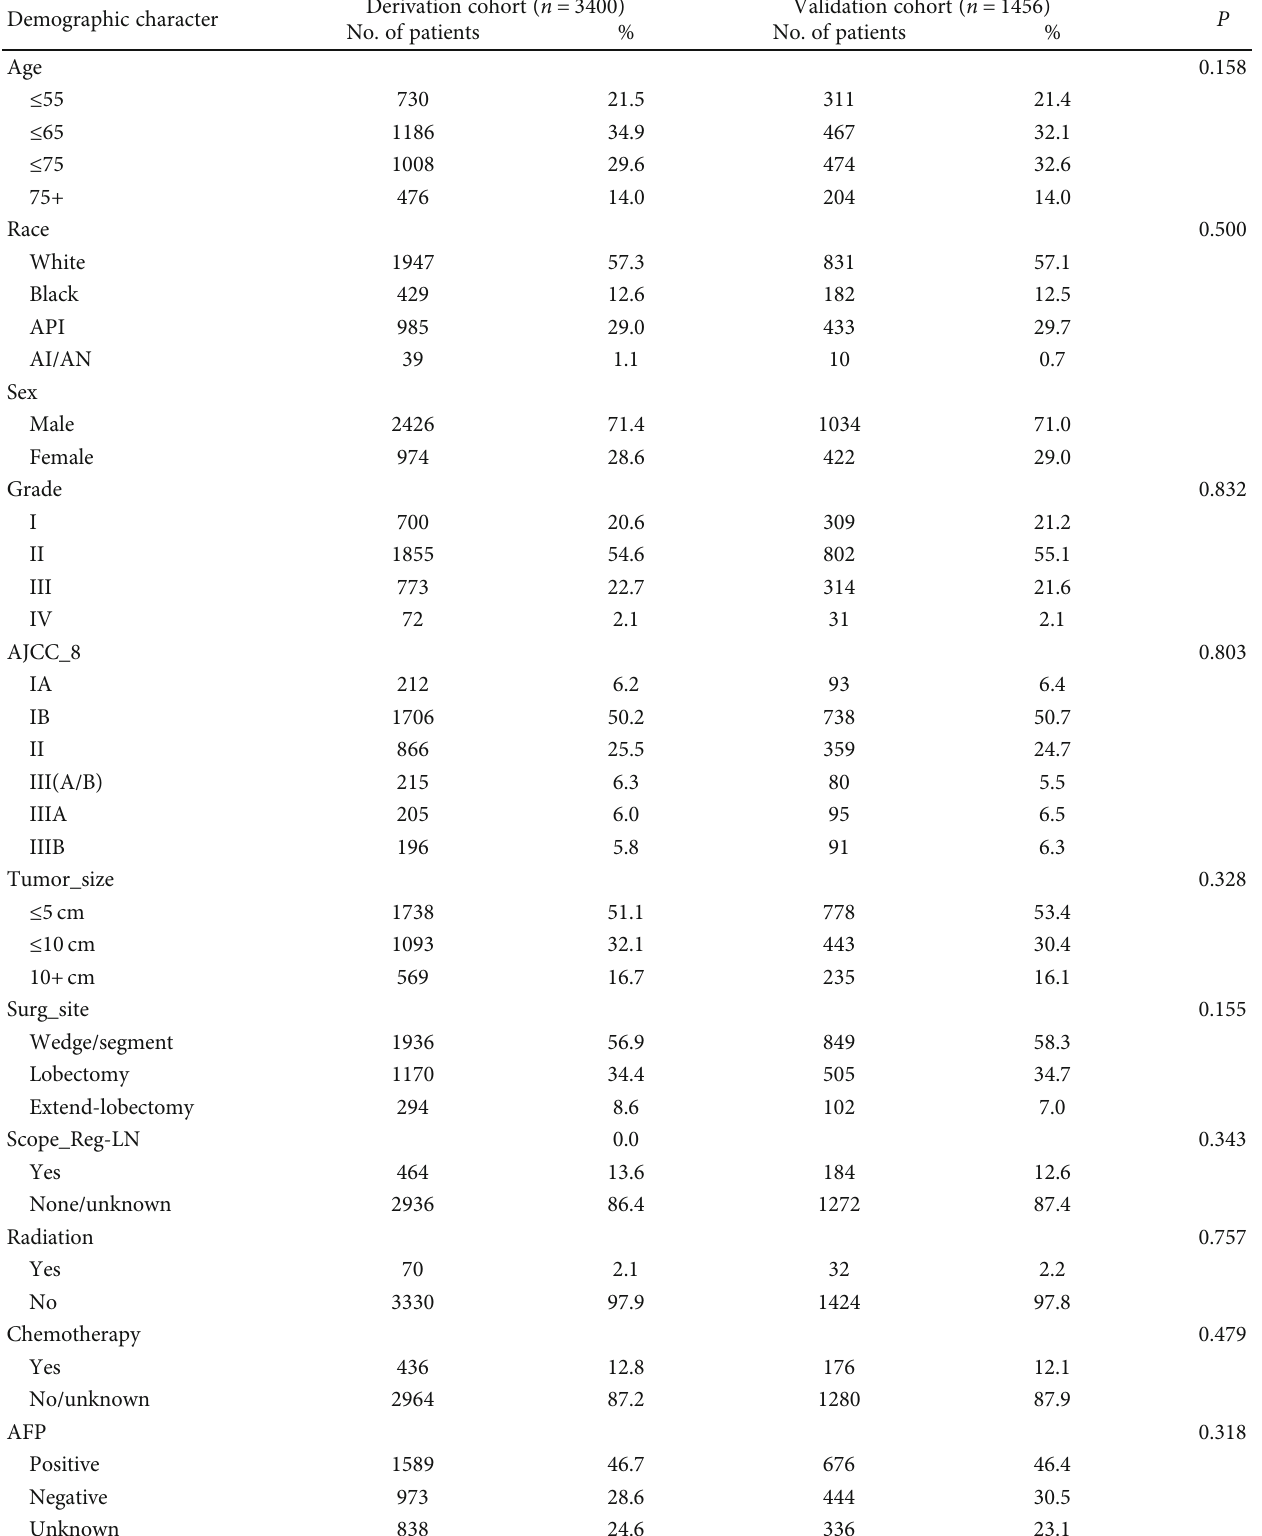
Table 1: Demographics and clinicopathologic characteristics of patients with HCC (Abbreviations: Surg_site: surgery of primary site; AFP: the highest serum α -fetoprotein level prior to treatment; Scope_Reg-LN: scope of regional lymph node surgery; Marital_status: marital status at diagnosis; API: Asian or Paci fi c Islander; AI/AN: American Indian/Alaska